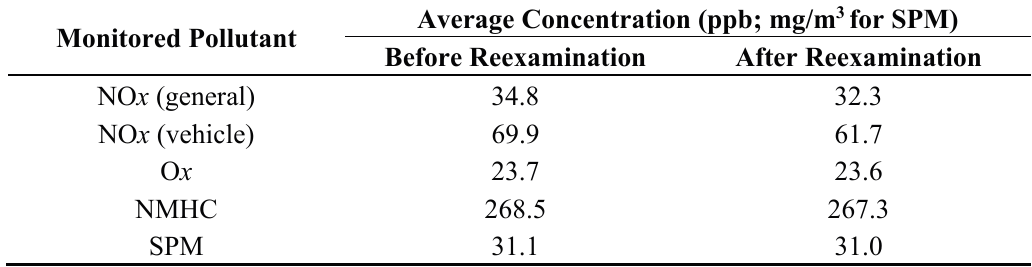
Figure 12. Mapping of air monitoring stations in semi-urban and urban areas before and after reexamination (retention ratios for the criteria were all 10%). Table 4. Average concentration of each pollutant before and after